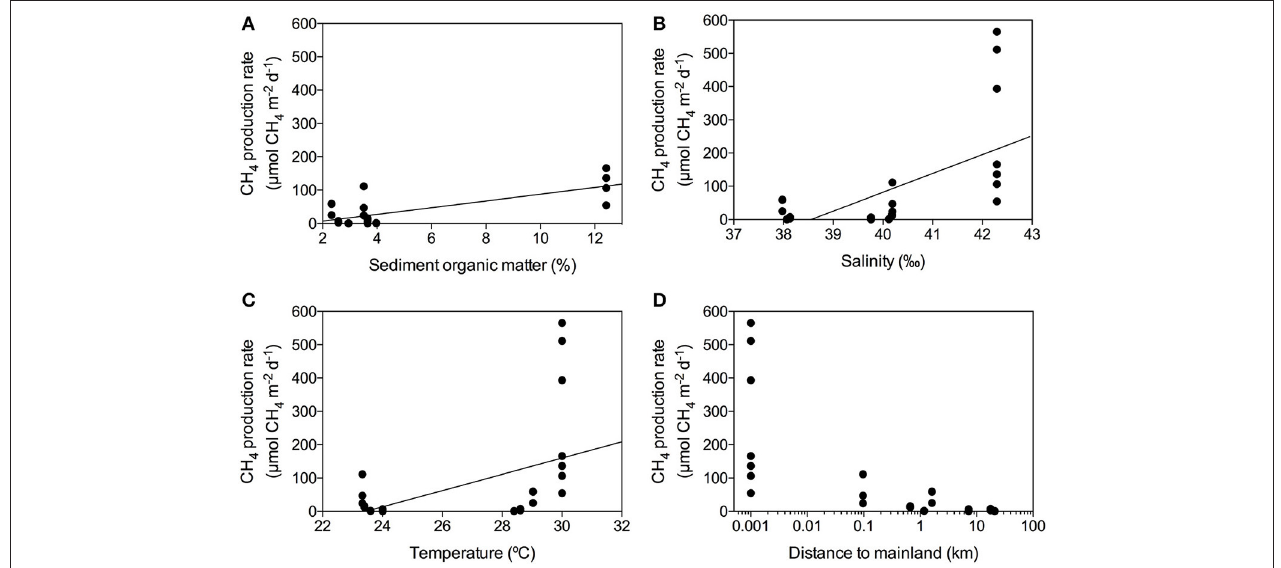
FIGURE 6 | Relationship of CH 4 production rates measured under light and dark conditions, showing line 1:1 (dashed line).